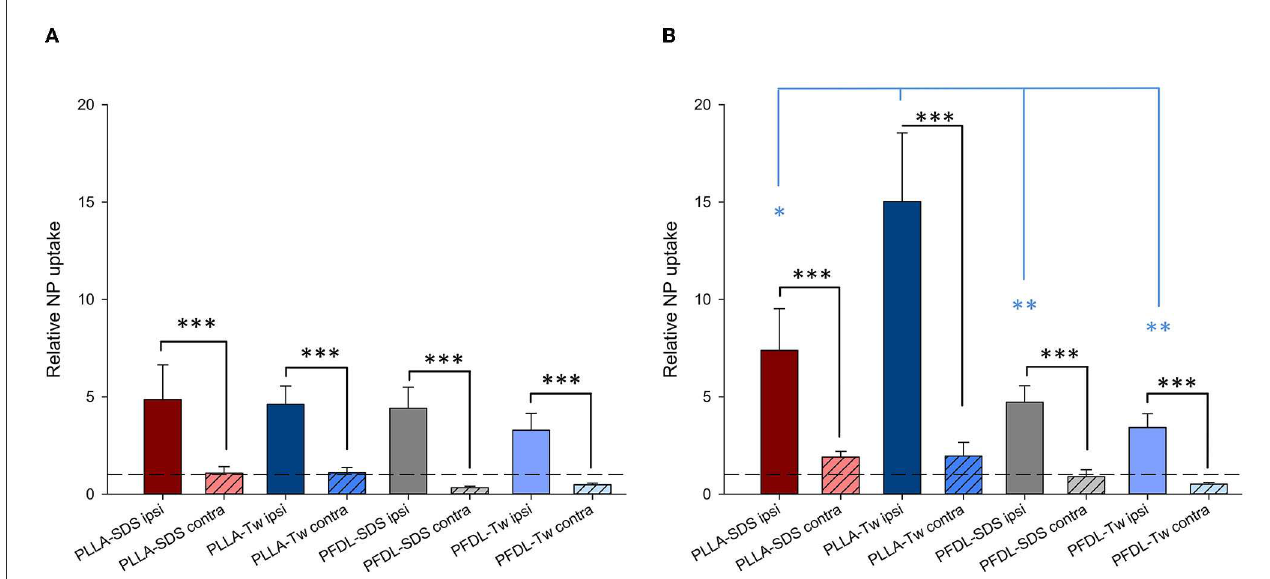
FIGURE8 Comparison of the relative NP uptake in CCI injured brains between the ipsi- and contralateral hemisphere at 4 (A) and 24h (B) after intravenous NP injection. Due to the differences in fluorescence intensity between NP types data were normalized as described in the method section. The dotted lines depicted at y = 1 represent the value from uninjured brain tissue. Paired t -tests were used for comparing ipsi- vs. contralateral ROIs in CCI injured animals (black asterisks), whereas one-way ANOVA was used for comparing the relative NP uptake within the injured area between different NP types (blue asterisks). Bars express means ± SEM. *** p < 0.001, ** p < 0.01, * p <